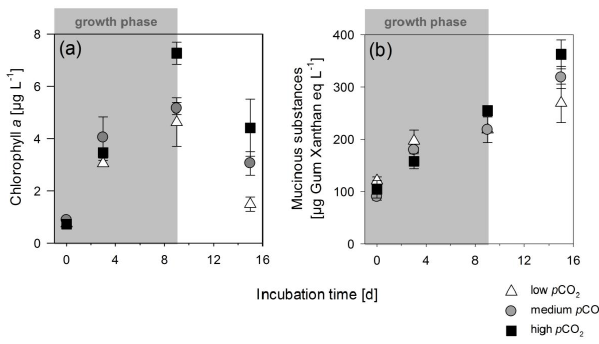
Fig. 1. Chlorophyll a concentration (a) and mucinous substance concentration (b) over time at low (triangle), medium (circle) and high (squares) p CO 2 . Symbols display the mean of three replicates with standard